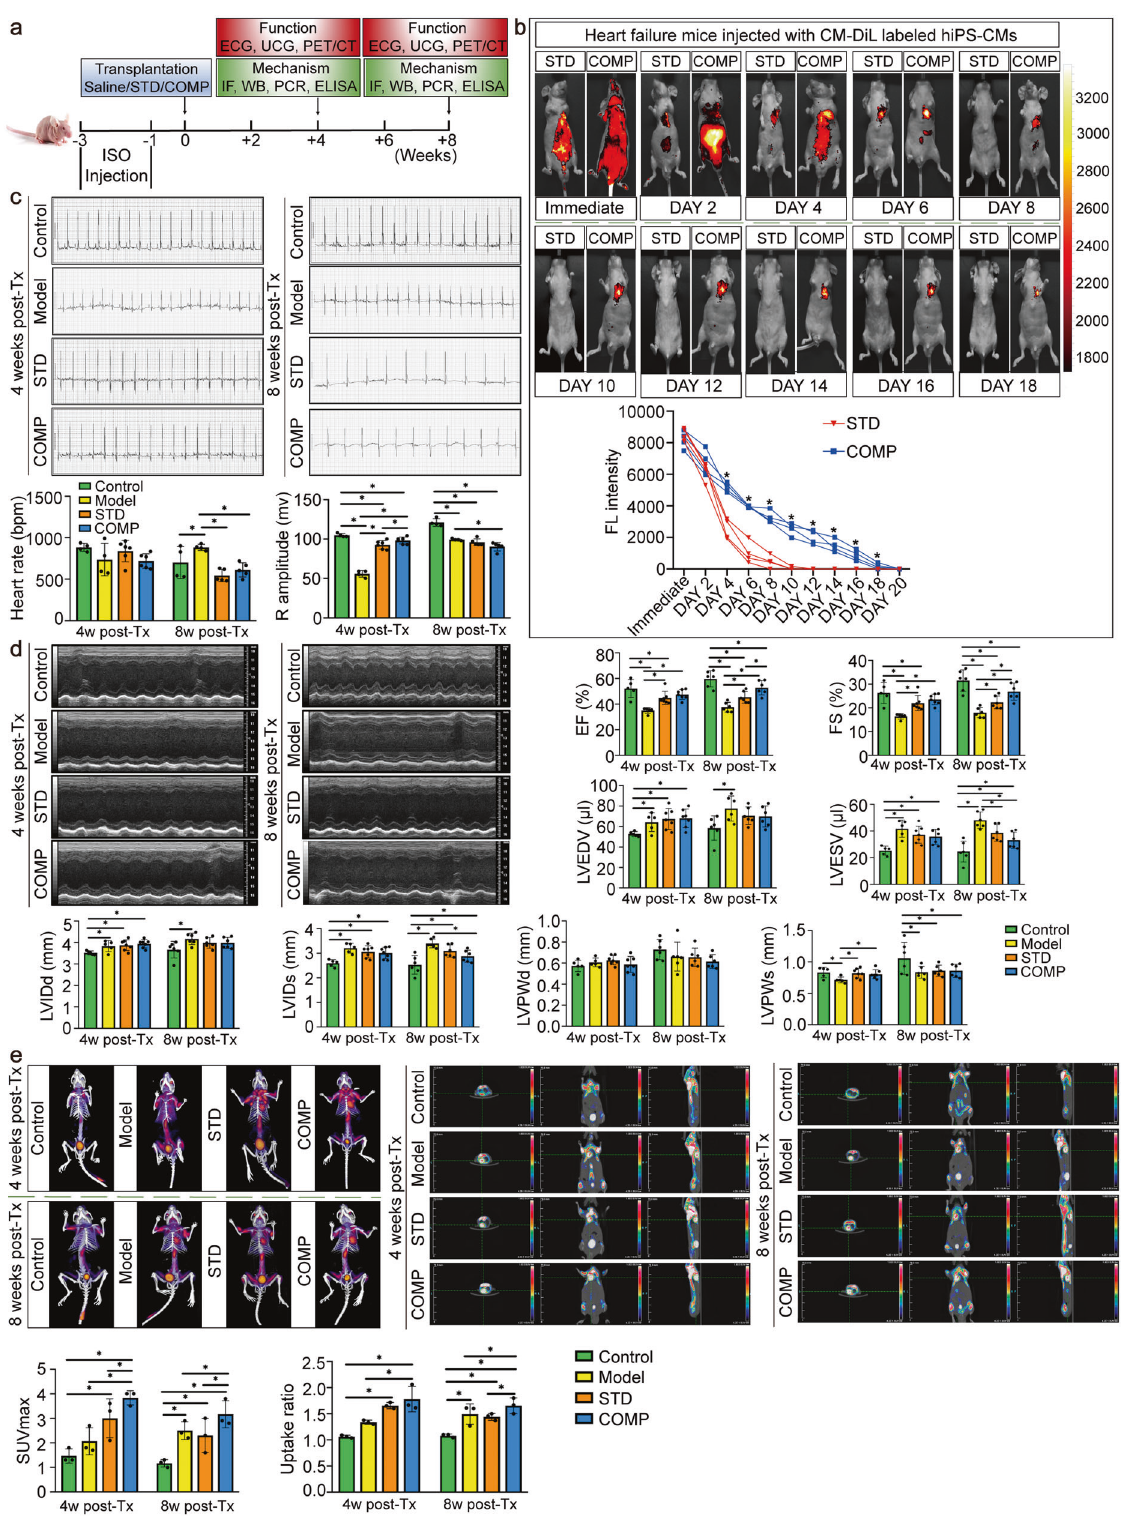
reticular. We know that the mitochondria of mouse embryos are fragmented on day 9.5, and only on day 13.5 do the mitochondria develop branching and form a thin, fi liform and interconnected network structure. 23 It could be seen that the